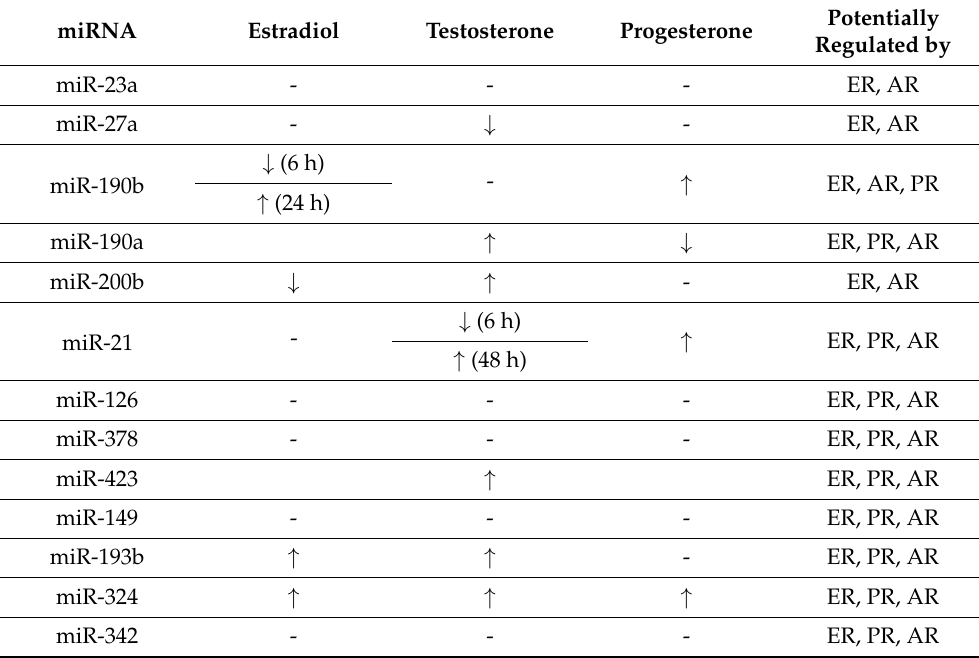
Table 6. The miRNAs potentially regulated by ER, PR, and AR. Data from [26]. Potentially miRNA Estradiol Testosterone Progesterone Regulated by miR-23a - - - ER, AR miR-27a - ↓ - ER, AR ↓ (6 h) - ↑ ER, AR, PR miR-190b ↑ (24 h) miR-190a ↑ ↓ ER, PR, AR miR-200b ↓ ER, AR miR-21 ER, PR, AR ↑ (48 h) miR-126 ER, PR, AR miR-378 - ER, PR, AR miR-423 ↑ ER, PR, AR miR-149 - ER, PR, AR miR-193b ER, PR, AR miR-324 ER, PR, AR